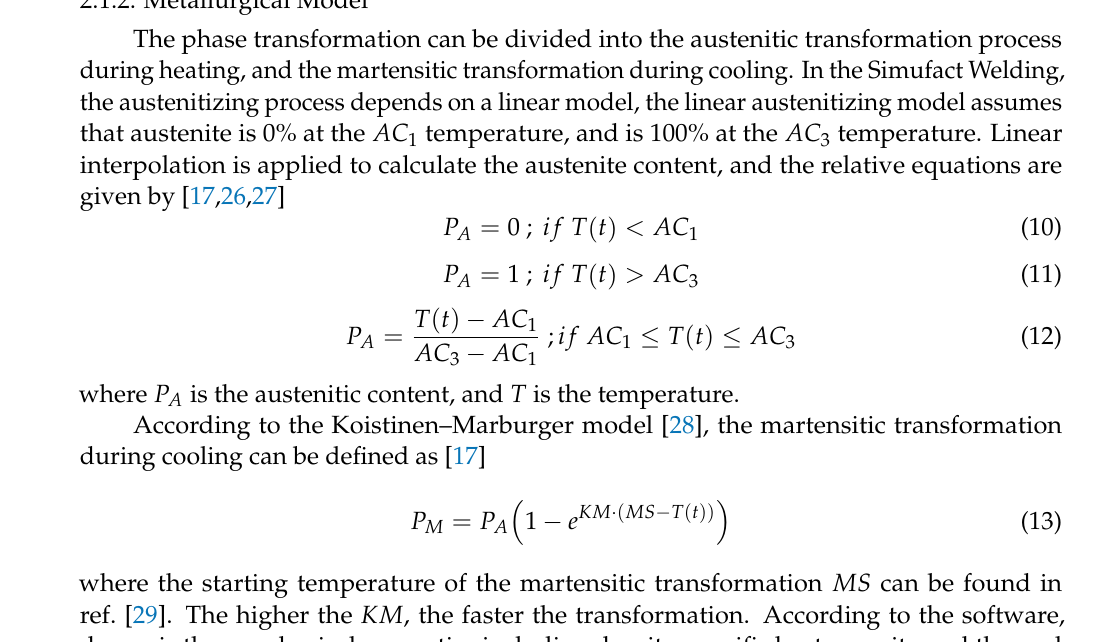
Figure 1. Finite element model: ( a ) Geometric model; ( b ) Heat source model. Table 1. Parameters of the heat source model.